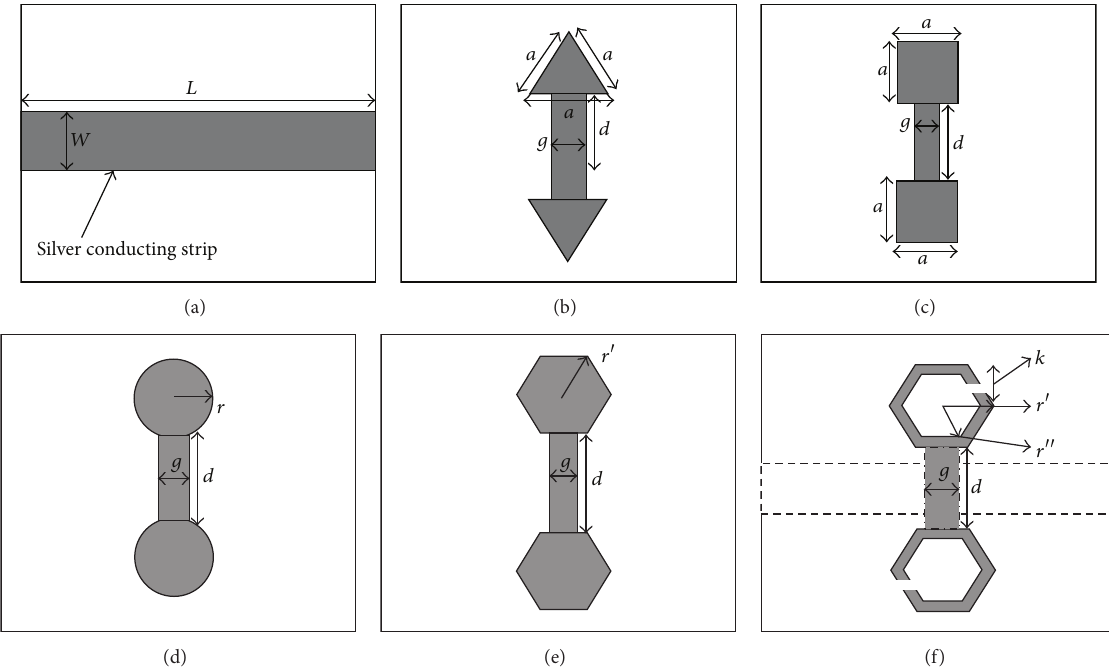
Figure 1: Various configurations of DB-DGS: (a) top view of microstrip line, (b) triangular DB-DGS, (c) square DB-DGS, (d) circular DB- DGS, (e) hexagonal DB-DGS, and (f) modified hexagonal DB-DGS.